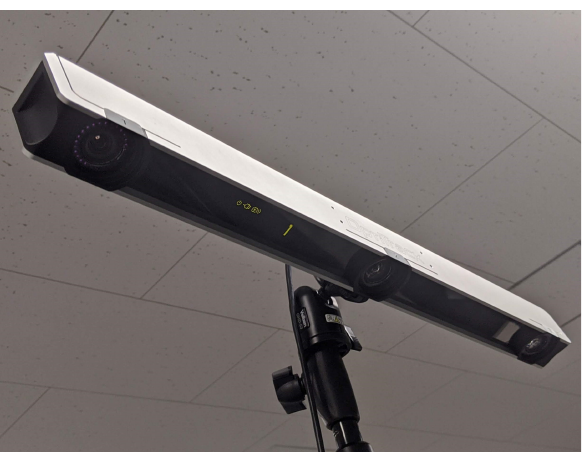
Figure 17. The motion-capture camera system of V120 Trio, developed by OptiTrack.